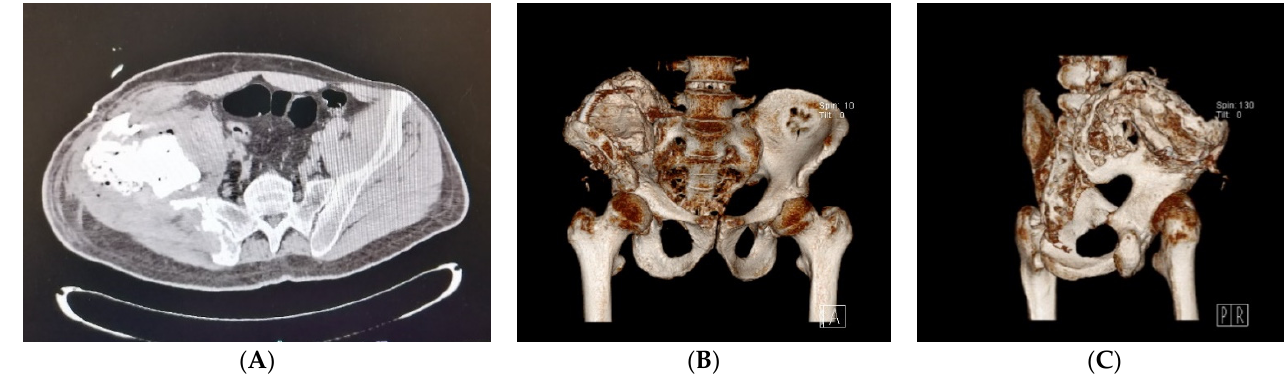
Figure 4. Postoperative CT scan ( A ) and 3D reconstruction ( B , C ) of the pelvis.